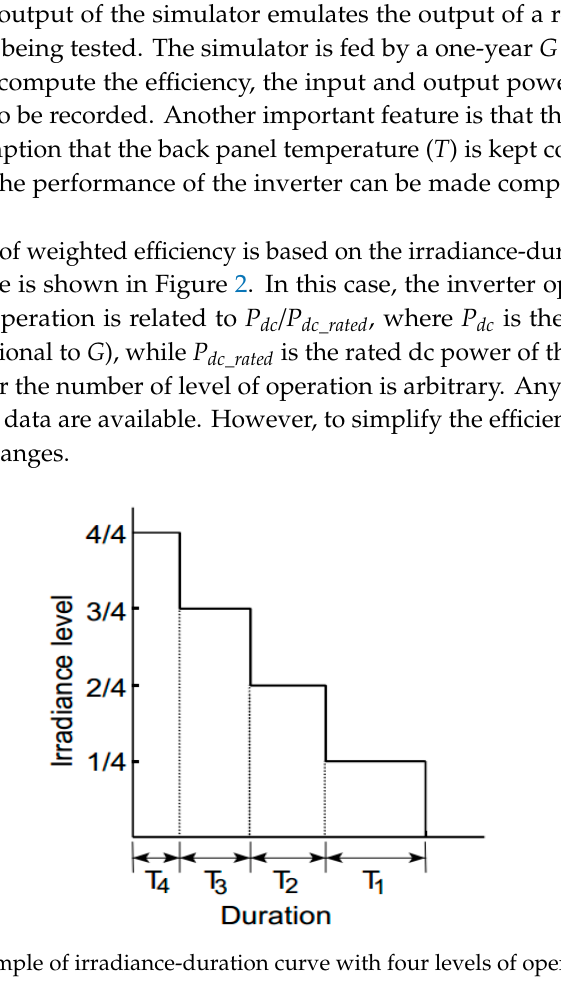
Figure 2. Example of irradiance-duration curve with four levels of operation [6–8].